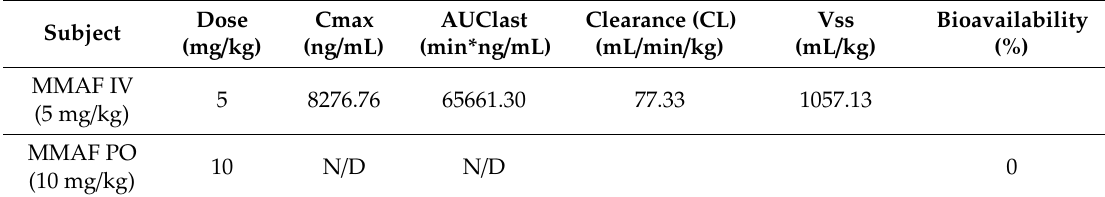
Table 6. Pharmacokinetic parameters of MMAF (monomethyl auristatin F) after intravenous / oral administration in rats.